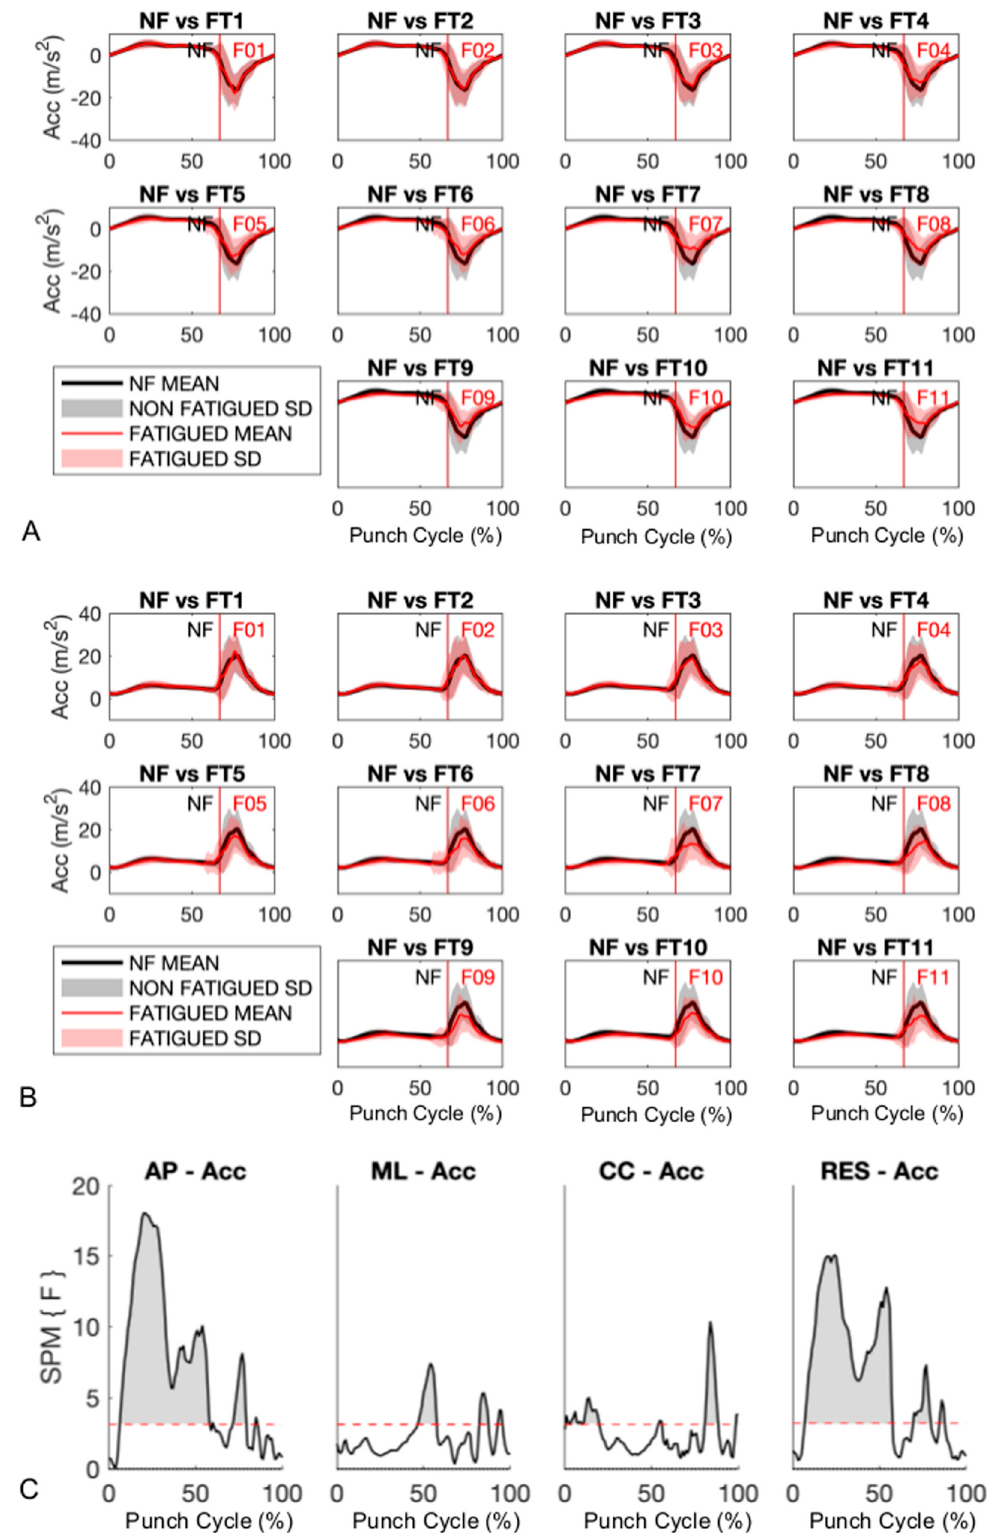
Figure 2. ( A ) Anterior–posterior (AP) component and ( B ) resultant accelerations. Vertical lines show average instant (% of cycle) of impact for non-fatigued (NF) and fatigued (F) trials, while 0% and 100% correspond to the beginning of the pre-impact and end of the impact phases, respectively. ( C ) Results from within-subject one-way ANOVA using a statistical parametric mapping approach (SPM{F}). ML — medial–lateral; CC — cranial–caudal; RES — resultant; Acc — acceleration.